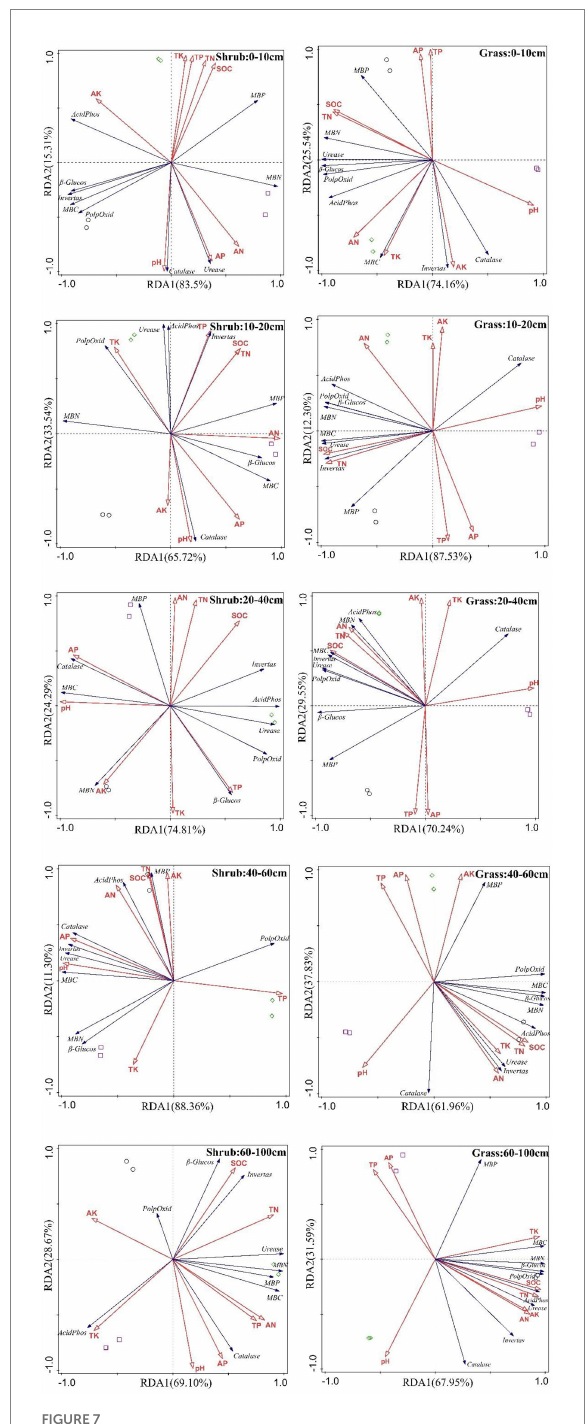
FIGURE 7 RDA analysis of soil enzyme activity, microbial biomass, and soil nutrients in all soil